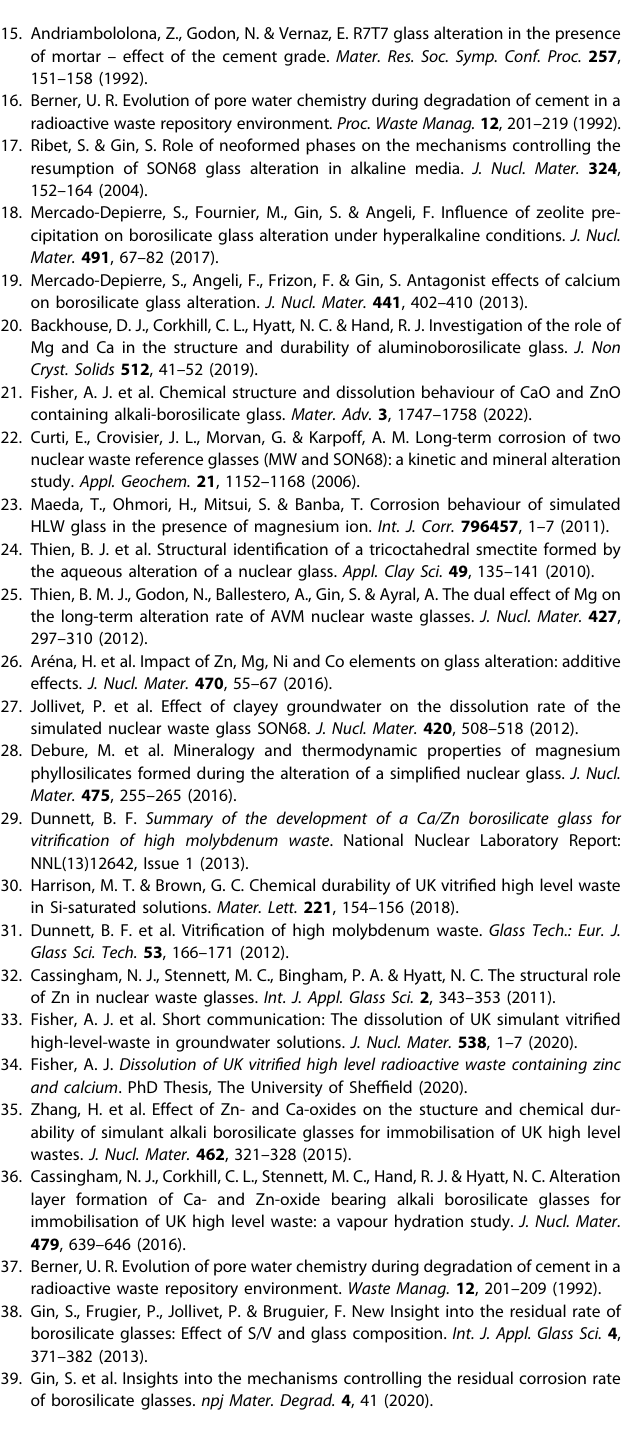
Errors represent one standard deviation of triplicate